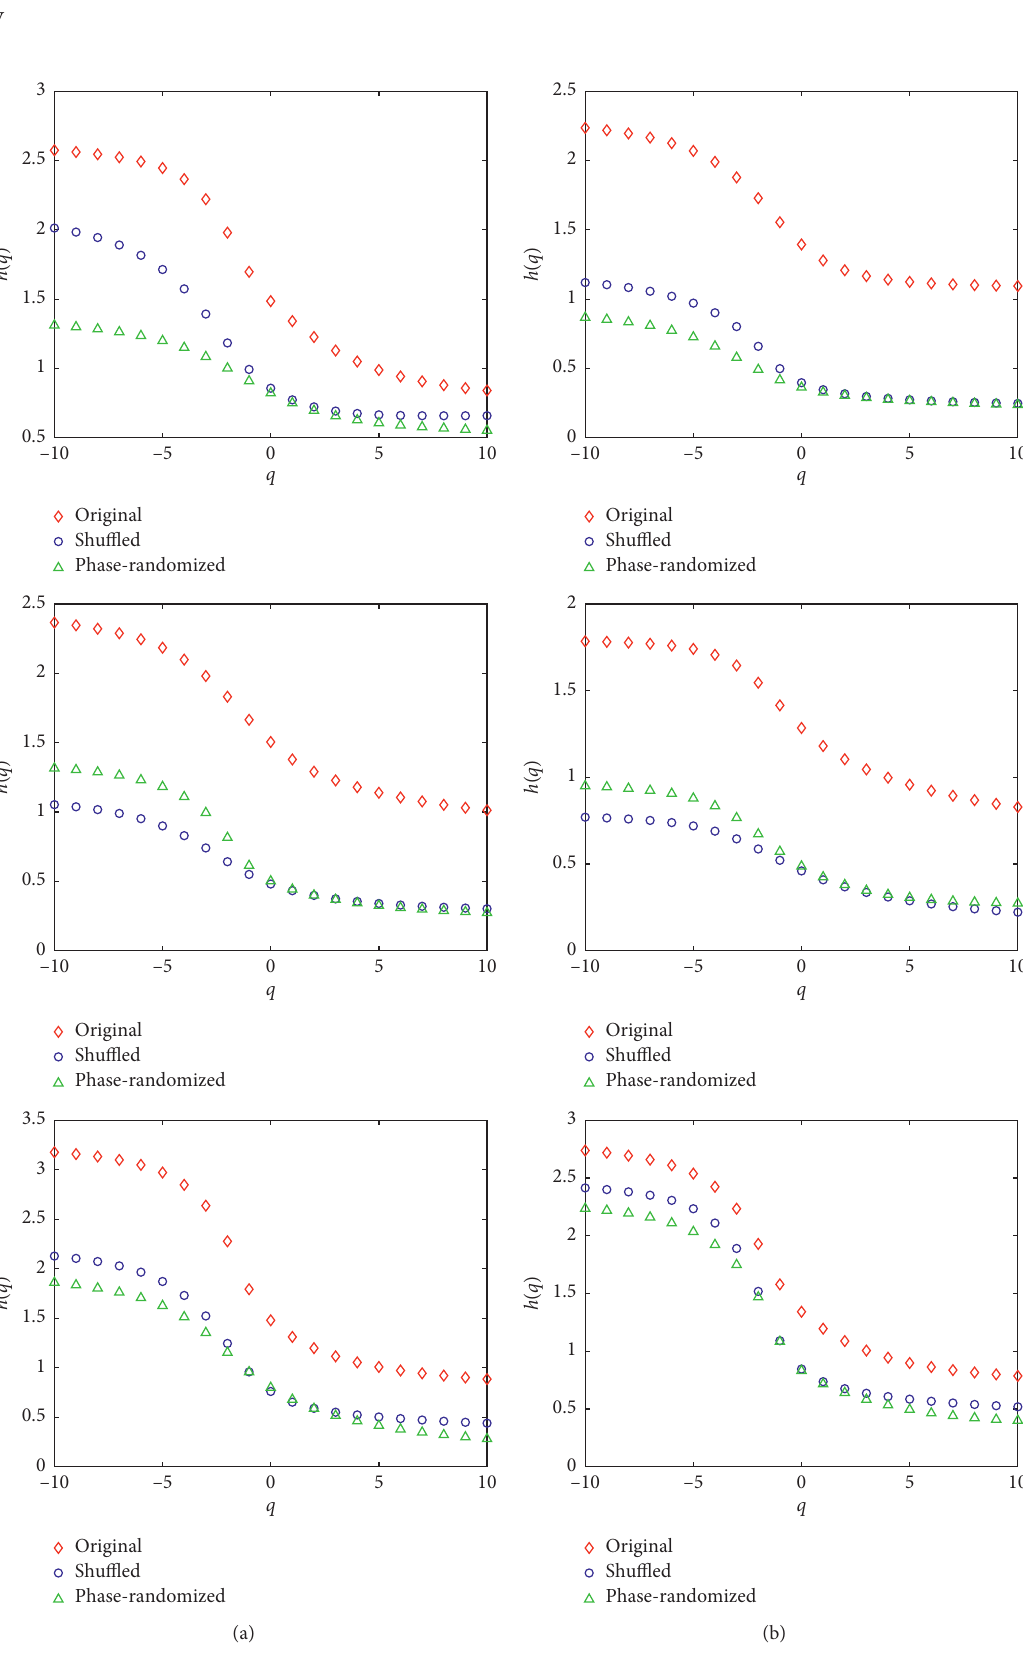
Figure 12: Hurst exponent (a) before law and (b) after law. From top to bottom are Seoul, Busan, and